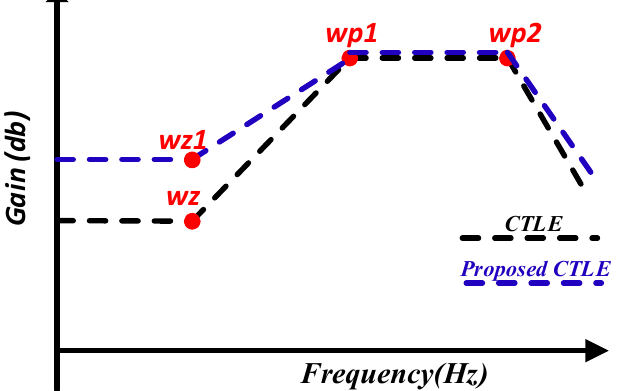
Figure 5. Single-ended Bode Plot of the Proposed CTLE.